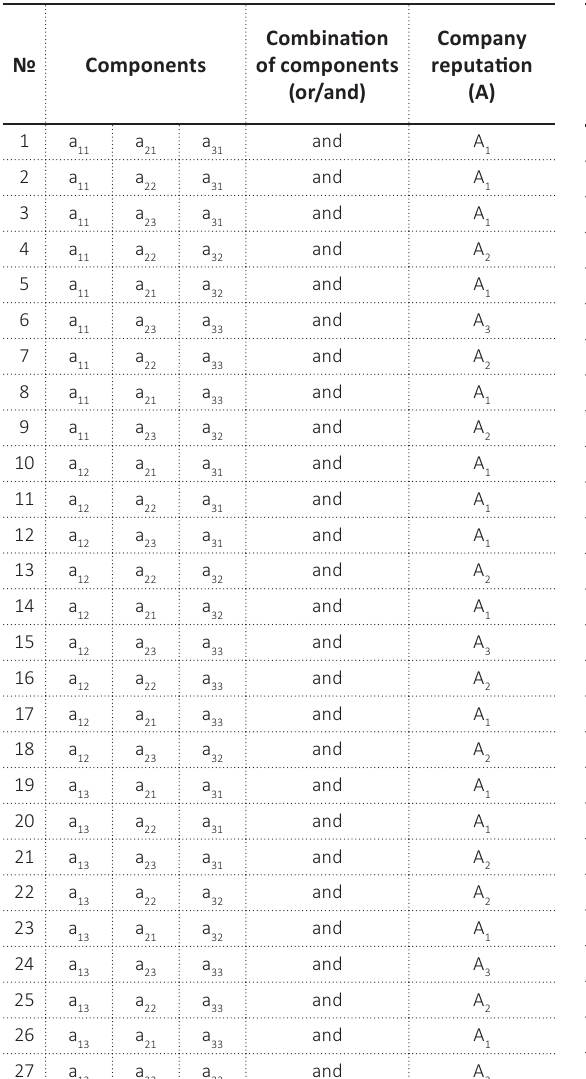
Table A5. Rules for forming an assessment of company reputation (А)